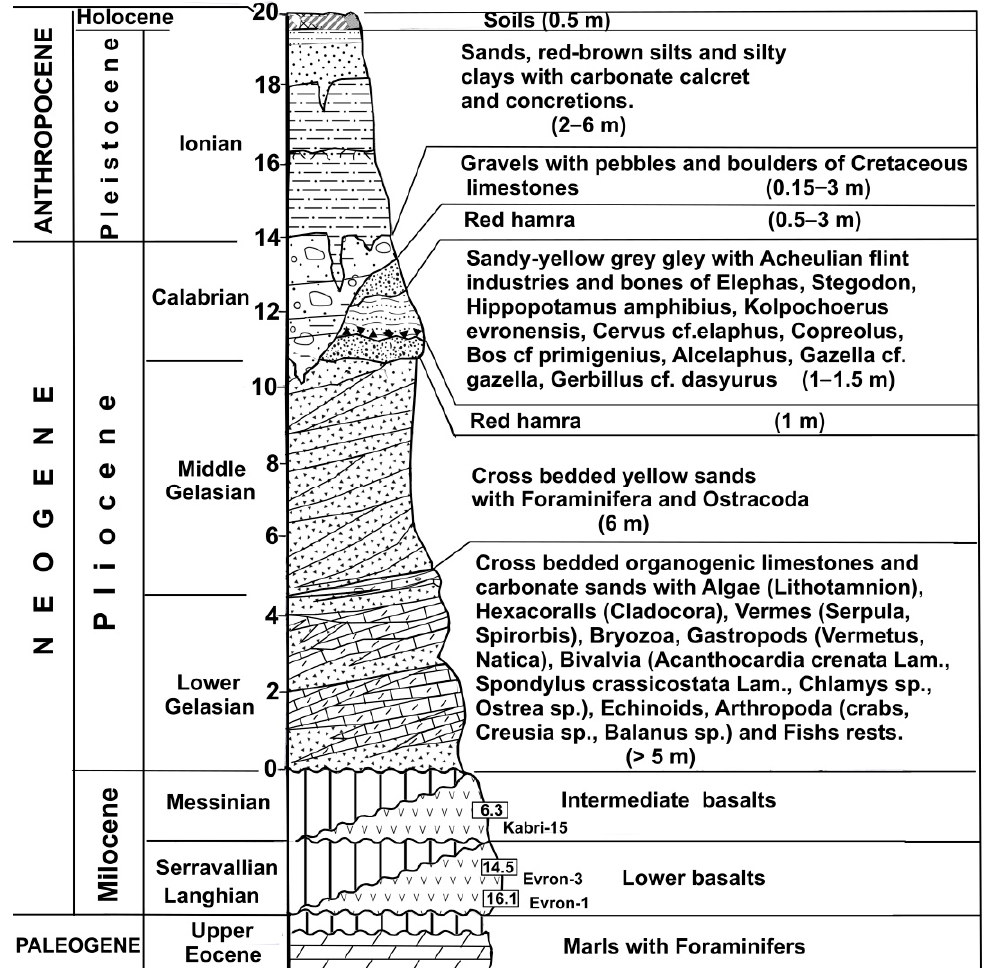
Figure 6. The stratigraphic sequence of the Upper Cenozoic sediments and traps of the Evron Quarry area in northern Galilee (northern Israel). Besides the personal studies of the authors of this paper, the following main works were used for this section construction: [12,15,40,41,88,104,105]. The marine Gelasian occurs on the sediments of the Cretaceous-Eocene carbonate platform. Above these formations are two complexes of Miocene traps, which are the west- be seen on the paleomagnetic map (Figure 4). Two complexes are developed